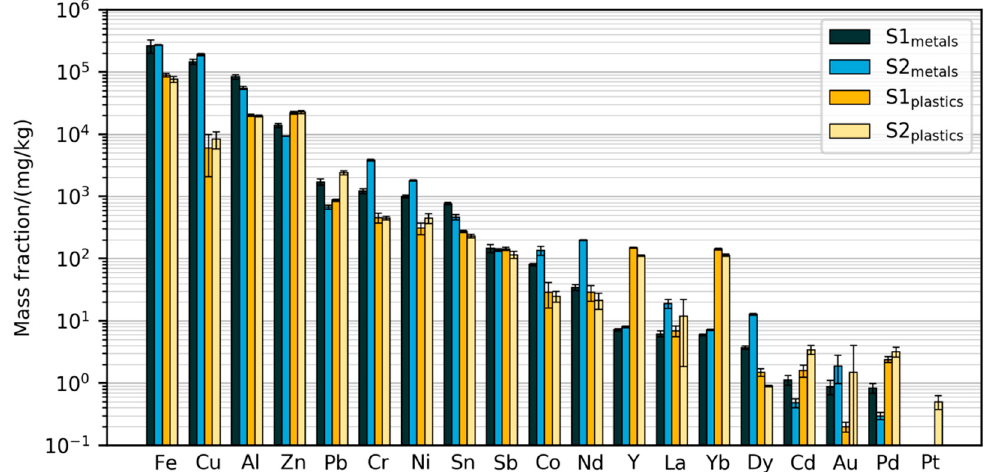
Figure 3. Mass fractions of elements measured with the validated method. Error bars show standard deviations from digestion and measurement of five test samples of 0.2 g each. Note that Y and Yb have been added to the primary samples.